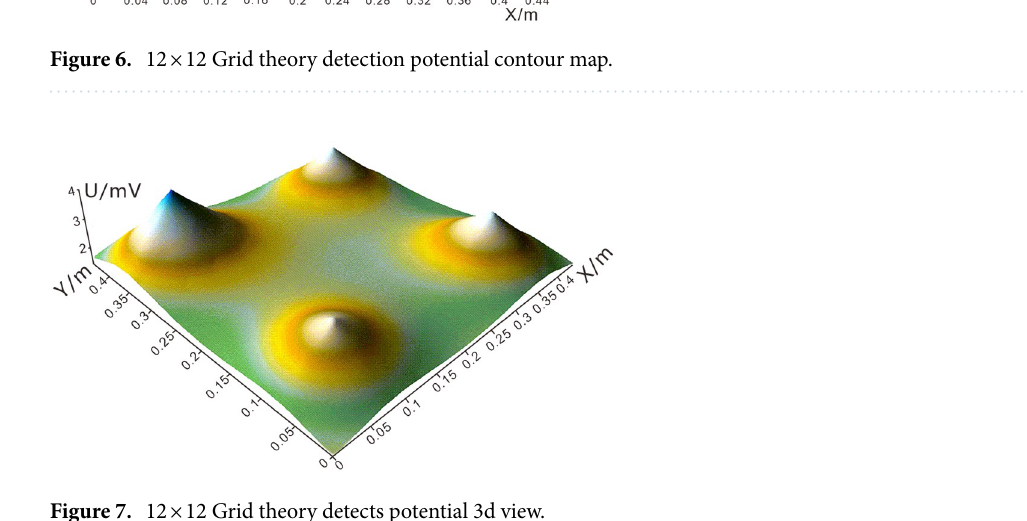
Figure 7. 12 × 12 Grid theory detects potential 3d